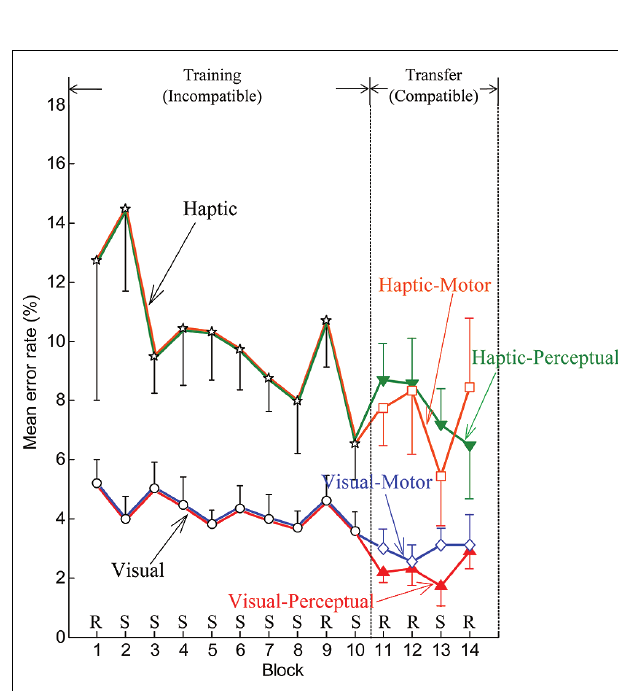
FIGURE 4 | Mean by group and subgroup of individual error rates for the training phase (blocks 1–10) and transfer phase (blocks 11–14). Error bars are ± 1 standard error of the mean. R and S stand for pseudorandom and sequenced stimuli, respectively.